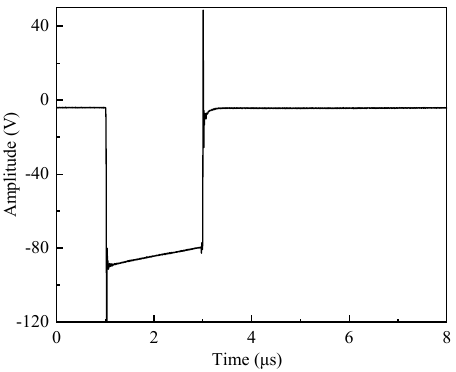
Figure 2. Time − domain waveform of the excitation signal.